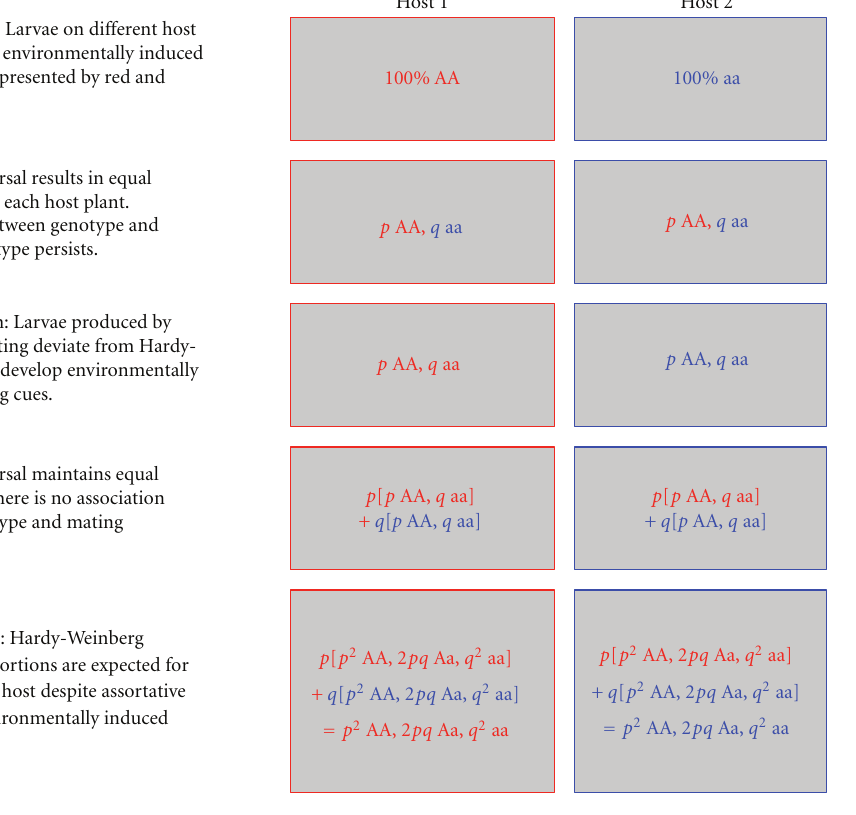
Figure 5: Free gene flow despite assortative mating. If mating cues are environmentally induced but there is no habitat choice, host-associated populations will not be genetically di ff erentiated, and it takes two generations to establish Hardy-Weinberg equilibrium. If the host densities are p and 1 − p = q , a locus that is fixed for di ff erent alleles on di ff erent hosts has allele frequencies p and q . At first, genotypes are perfectly associated with the host-induced mating cue, but random dispersal eliminates that association in one generation if there are no other factors maintaining covariance between parent and o ff spring phenotype (e.g., maternal e ff ects or divergent selection). Once genotype frequencies are equalized between phenotypes, mating within phenotypes establishes Hardy-Weinberg genotype proportions [61]. Although imagining a locus with complete di ff erentiation makes for the simplest illustration, the result is completely general for any allele frequency. If we somehow know what alleles have ancestors in each habitat in generation 0, the result is that it takes just two generations to completely randomize that ancestry, regardless of whether or not the alleles are actually di ff erent by